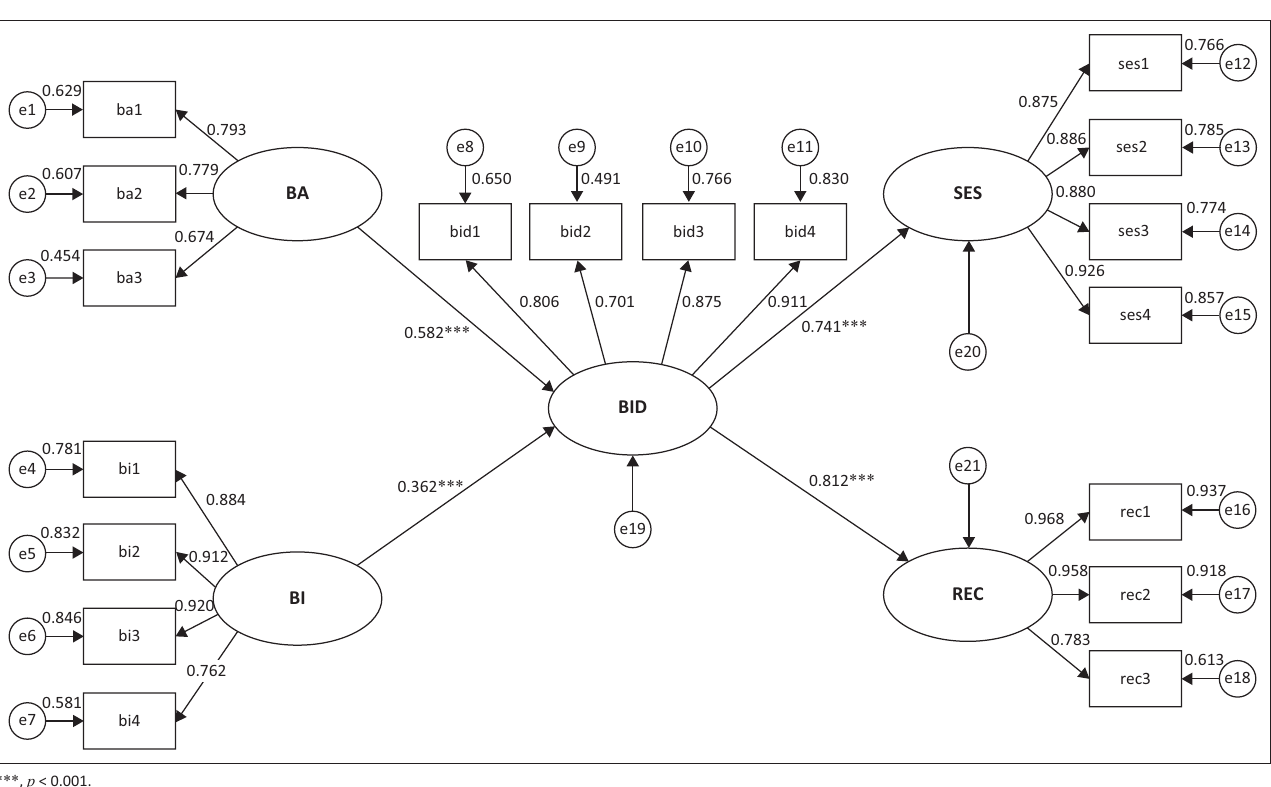
FIGURE 1: Structural equation modelling of the theoretical